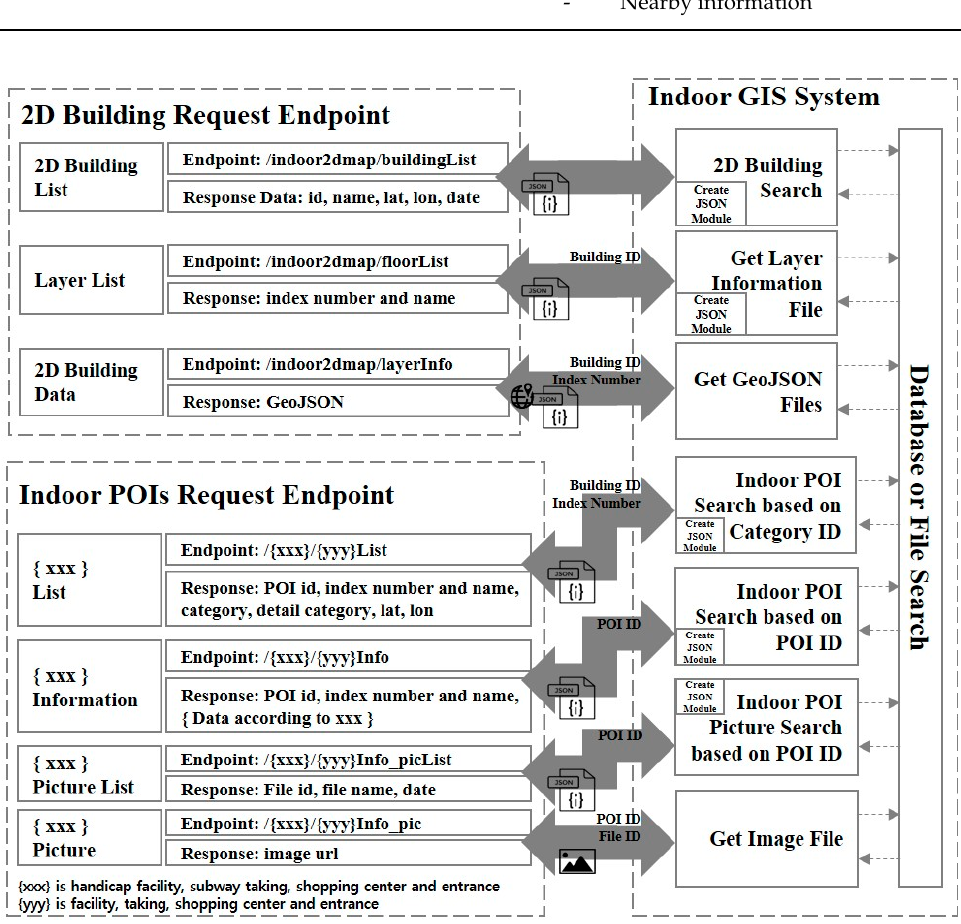
Figure 6. Conceptual view of request and response processing for an indoor POI and a 2D building.